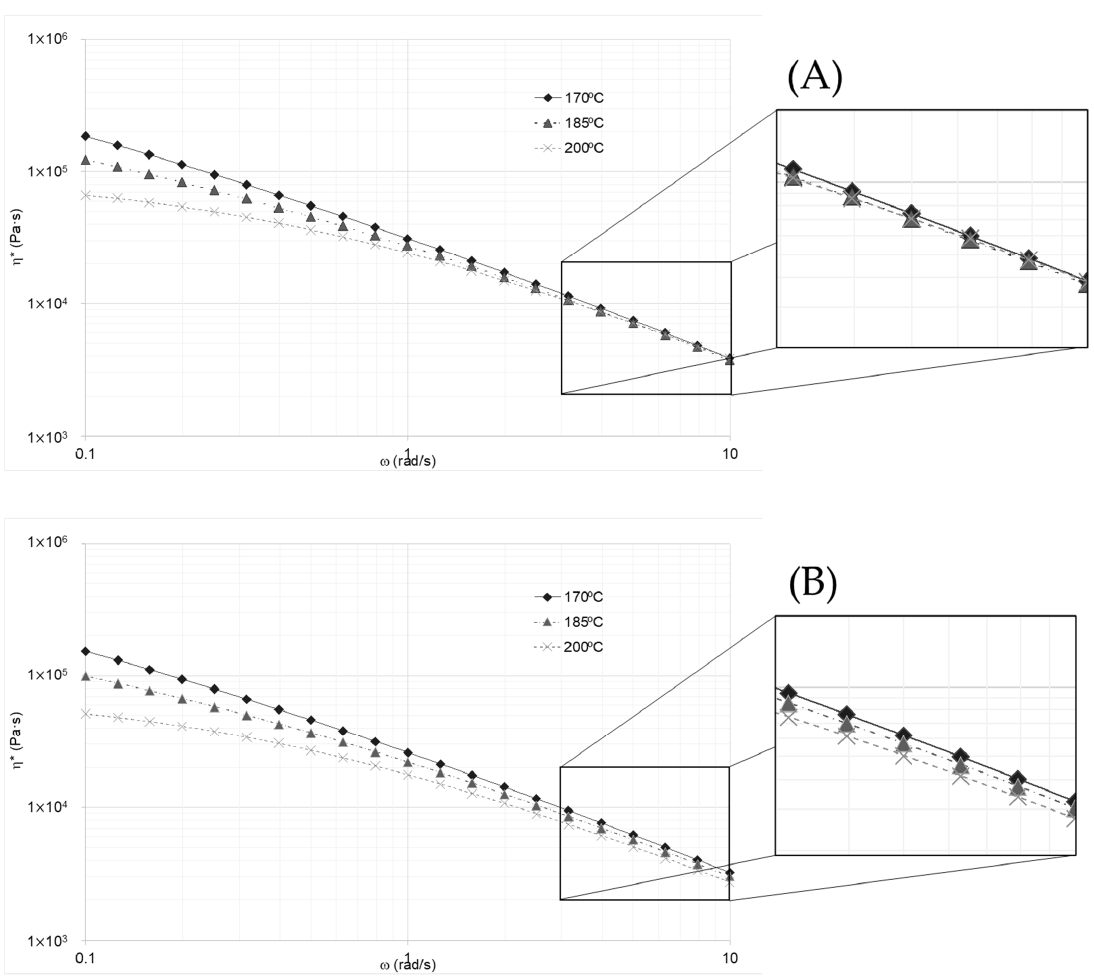
Figure 4. ( A ) Complex viscosity curves for resin A at different temperatures collapsing at high frequencies, ( B ) adjusted complex viscosity of resin A at different temperatures after correction for swelling, splitting off at high frequencies.